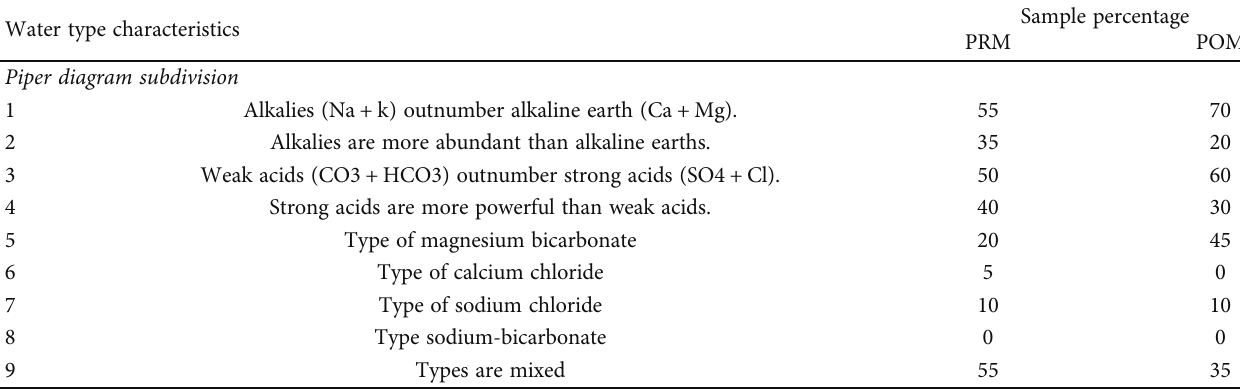
Table 5: Piper tri-linear and Chadha diagram were used to characterise groundwater. Water type